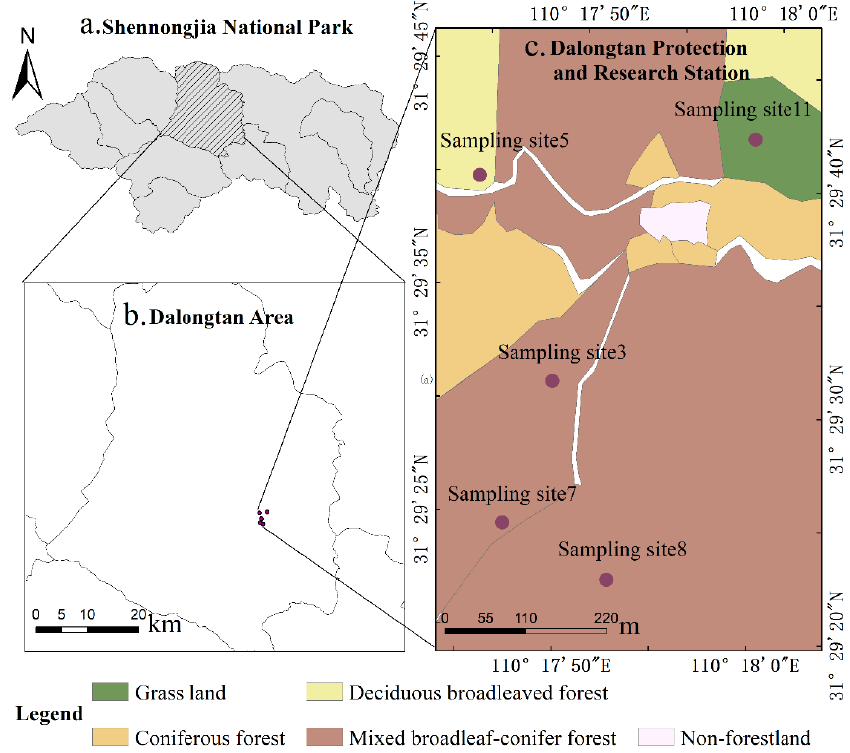
Figure 1. Study area and sampling sites. ( a ) Location of Dalongtan in Shennongjia National Park; ( b ) location of protection and research station in Dalongtan area; ( c ) sampling area and distribution of sampling sites.